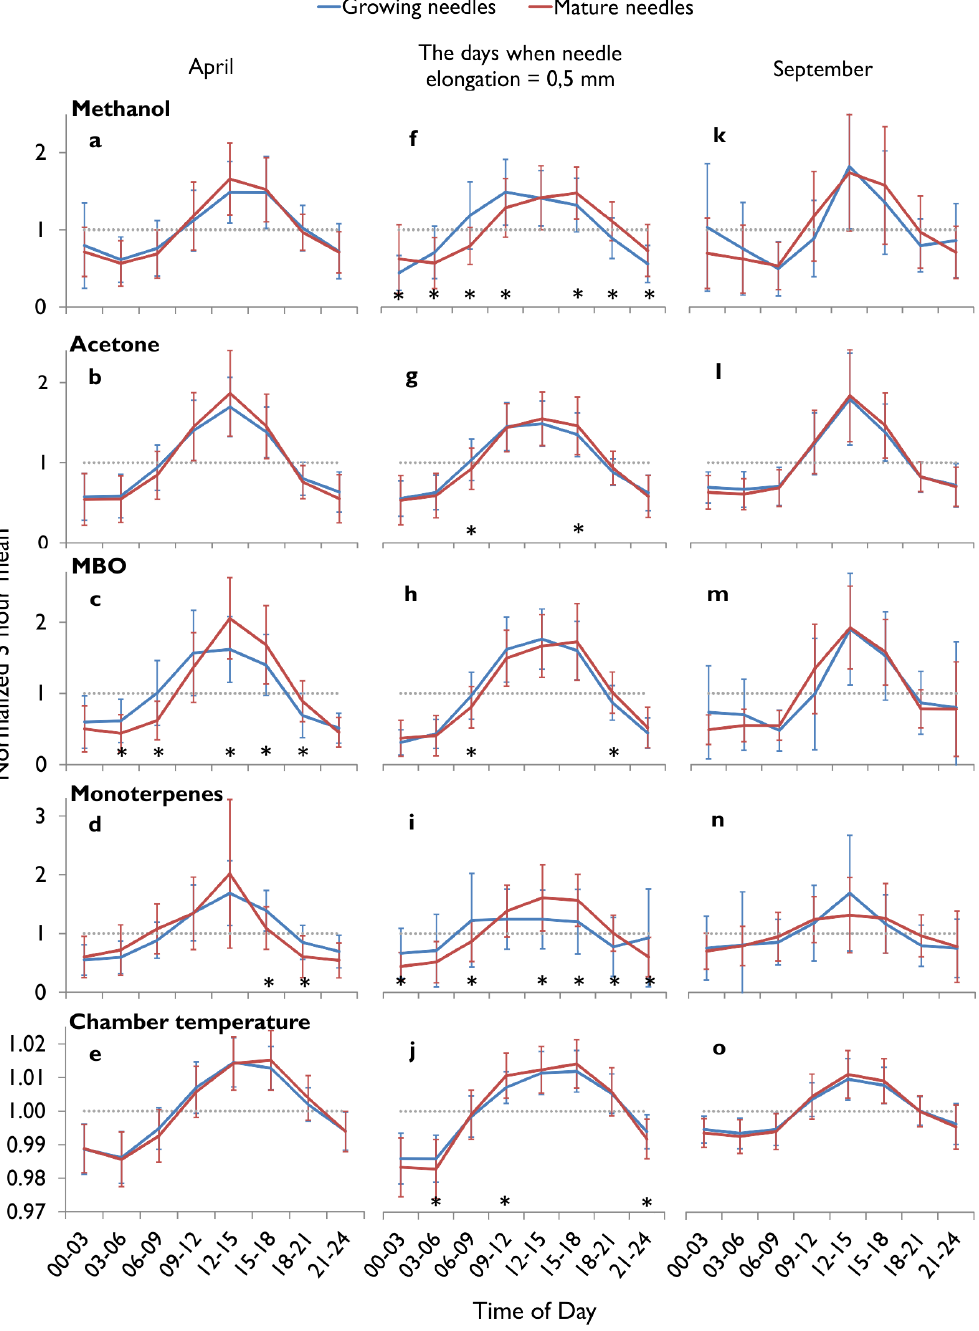
Fig. 7. The average diurnal cycle in VOC emissions from mature and developing Scots pine shoots in April before the onset of shoot growth (a–d) , during the most intensive needle elongation days (needle elongation ≥ 0.5mmd − 1 , (f–i) ) and in September when growth has ended (k–n) . The y axis values are the 3-hour average emission rates normalized to the average of each day. The grey dashed lines show the normalized daily averages (= 1). The error bars equal ± 1 SD. The stars show statistically significant differences ( t test, p ≤ 0 . 05) in the normalized emissions between the developing and the mature shoot. The data is for the years 2009–2011 ( n = 11 − 67days, mostly > 30 days). The three figures on the bottom (e, j and o) show the normalized average diurnal cycles in chamber temperatures during the corresponding days, calculated from the temperatures in Kelvin